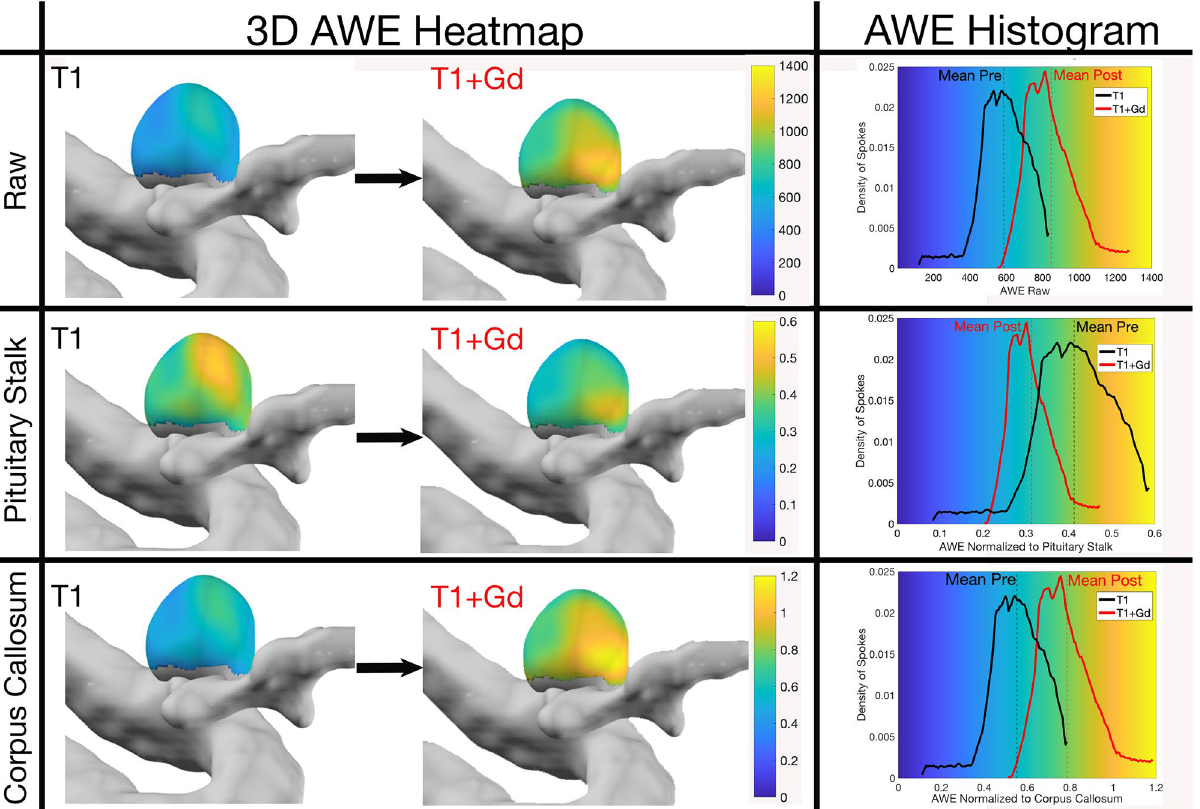
Figure 2. 3D heatmaps of T1 and T1 + Gd AWE of a PICA aneurysm. Histograms were generated from 3D maps: y axis = spoke density and x axis = AWE raw values (first row) and AWE ratios for the PS (second row) and corpus callosum (third row). The corpus callosum was a better structure for normalization and had an almost identical curve when compared to raw values (first and third rows). Avid PS Gd enhancement shifts the ratio to the left in T1 + Gd images (middle row). This aneurysm is highly enhancing as show in T1 + Gd images. AWE aneurysm wall enhancement, PICA posterior inferior cerebellar